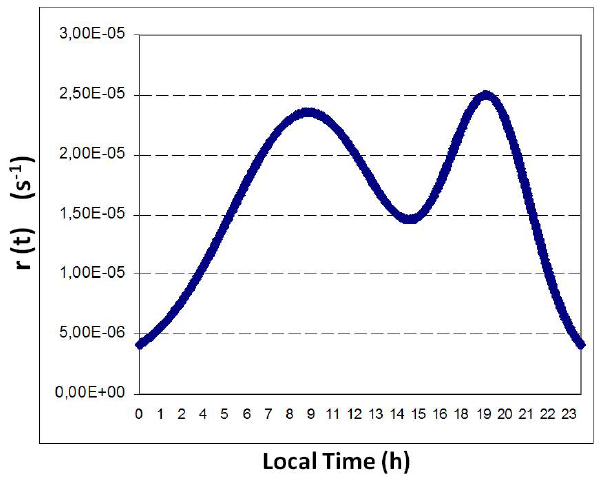
Fig. 2. A double Gaussian function used to determine the diurnal cycle of urban